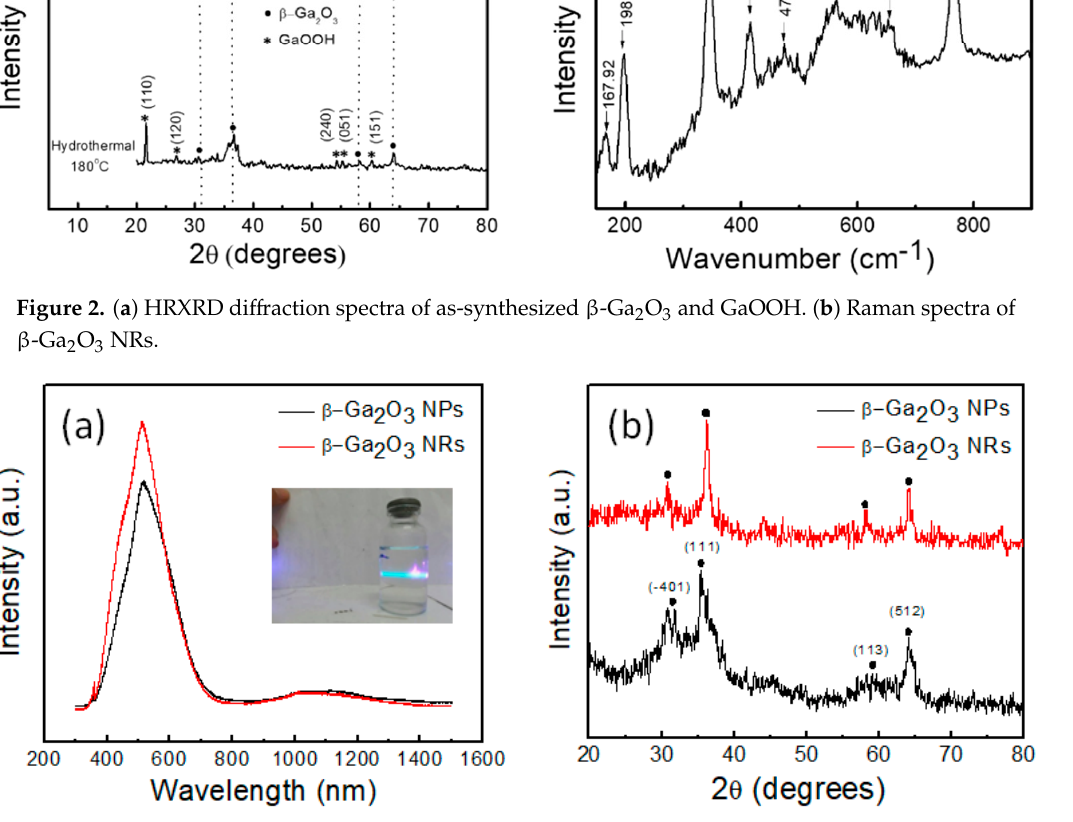
Figure 3. ( a ) Photoluminescence (PL) spectra of the synthesized β -Ga 2 O 3 NRs and NPs. Inset: digital image of green photoluminescence of β -Ga 2 O 3 NRs dissolved in DI water under a 365 nm UV irradiation. ( b ) HRXRD di ff raction spectra of synthesized β -Ga 2 O 3 NRs and